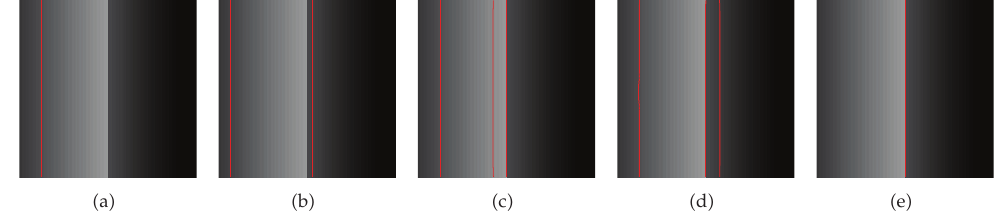
Figure 6: Comparison between the other models and the proposed model for a synthetic inhomogeneous image. The original image with the initial contour, the final contours with the CV model, the LBF model, the LGIF model, and the proposed model are shown in (cid:6) a (cid:7) – (cid:6) e (cid:7) , respectively.